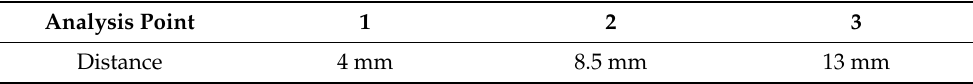
Figure 6. Characteristics of the XRD analysis: ( a ) analysis points; and ( b ) analysis directions. Table 2. Analysis distance from the entry surface of the drill tool.